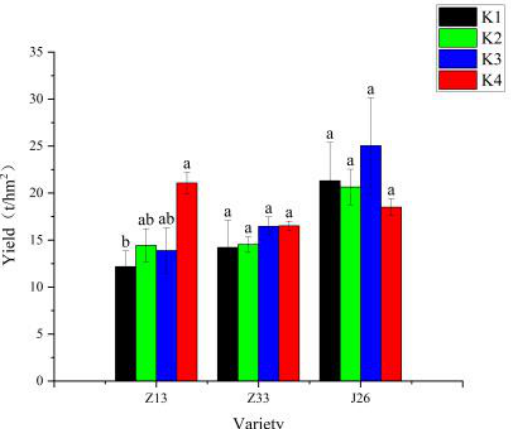
Figure 1. Yield of the tuberous root of different UCZ treatments after harvest. Values within the same storage day followed by the same letter are not significantly different at the 5% level according to ANOVA-Duncan’s multiple range test. The bar represents standard deviation. K1: Normal basal fertilizing without UCZ; K2: Normal basal fertilizing with UCZ; K3: Rich basal fertilizing without UCZ; K4: Rich basal fertilizing with UCZ.